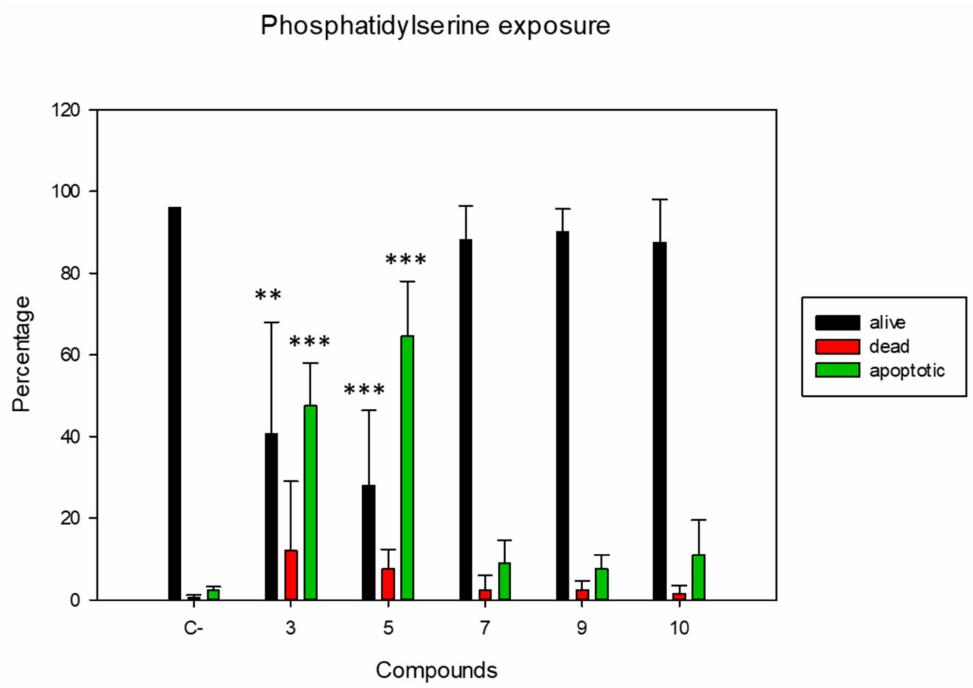
Figure 4. Results of the phosphatidylserine exposure after 48 h of incubation with the IC 90 of the molecules. Images were captured using a Tali image-based cytometer. C-: Negative control (not treated parasites). Error bars represent the standard deviation (SD). Each data point indicates the mean of the results of three measurements (***) p < 0.001, (**) p <